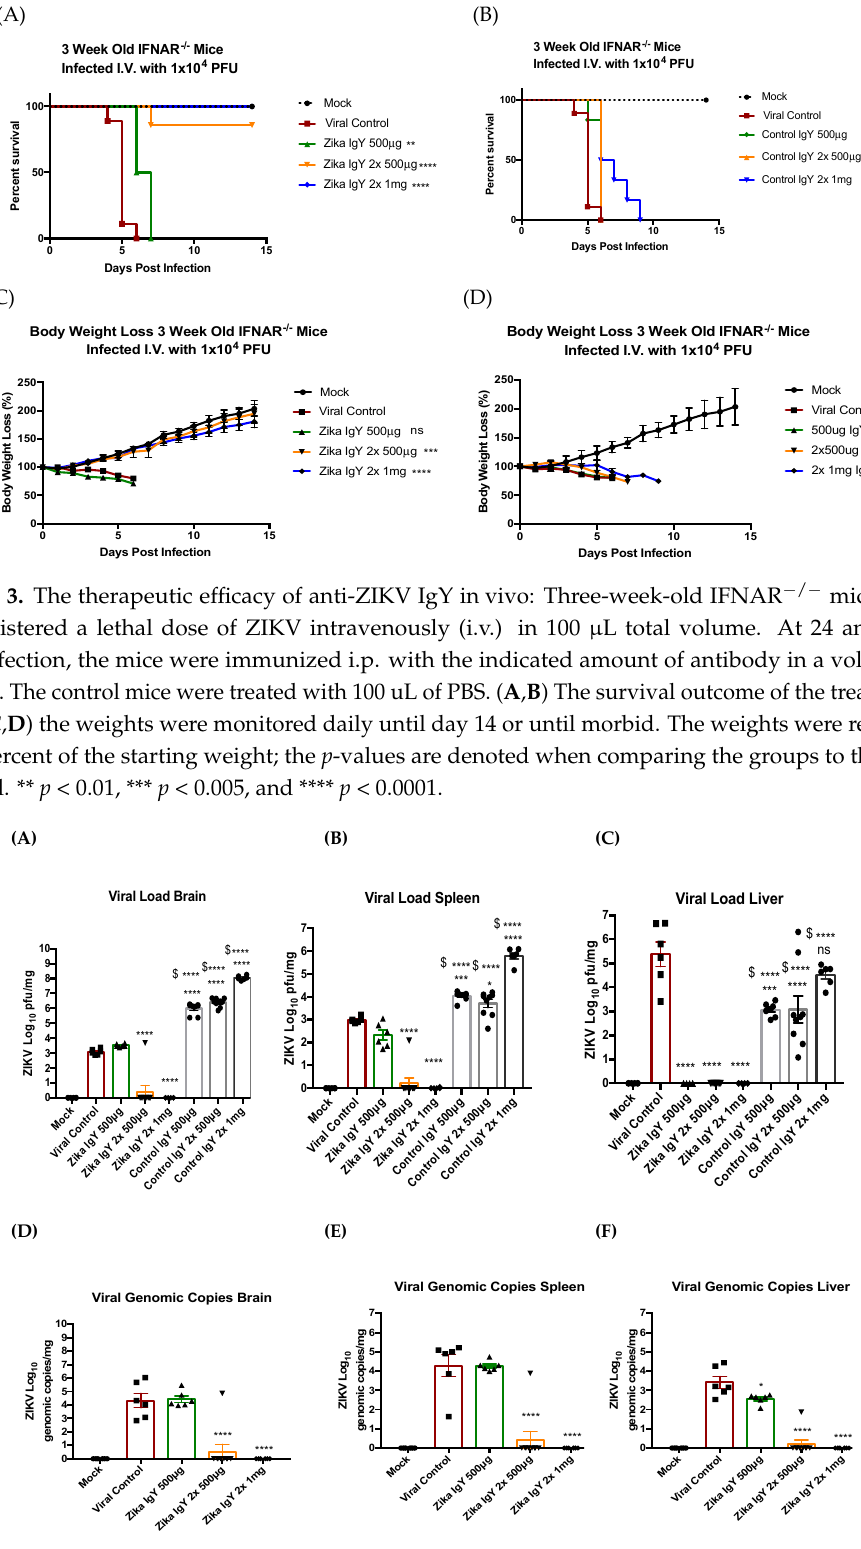
Figure 4. The viral load reduction upon treatment with anti-ZIKV IgY: ( A – C ) The infectious viral load was quantified in the brain ( A ), spleen ( B ), and liver ( C ) via a plaque assay. ( D – F ) The viral genomic copy number was quantified in the brain ( D ), spleen ( E ), and liver ( F ) via RT-qPCR. The viral load of the treated mice was compared to the viral control group. * p < 0.05, ** p < 0.01, *** p < 0.005, **** p < 0.0001, and $ is the comparison to the matching ZIKV-specific IgY group.